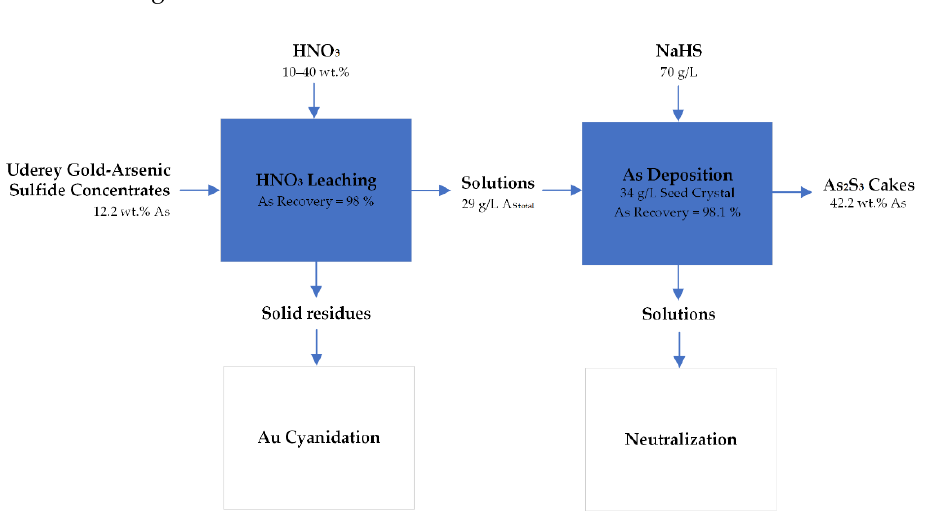
Figure 13. The flowchart of the leaching and further arsenic (III) sulphide precipitation